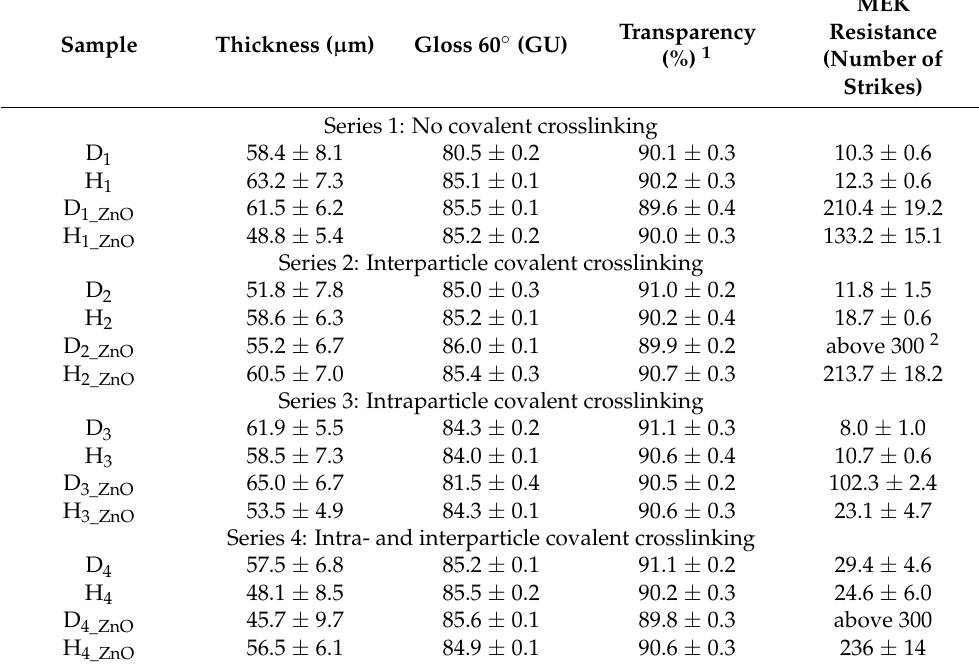
Table 8. Properties of coatings cast on glass